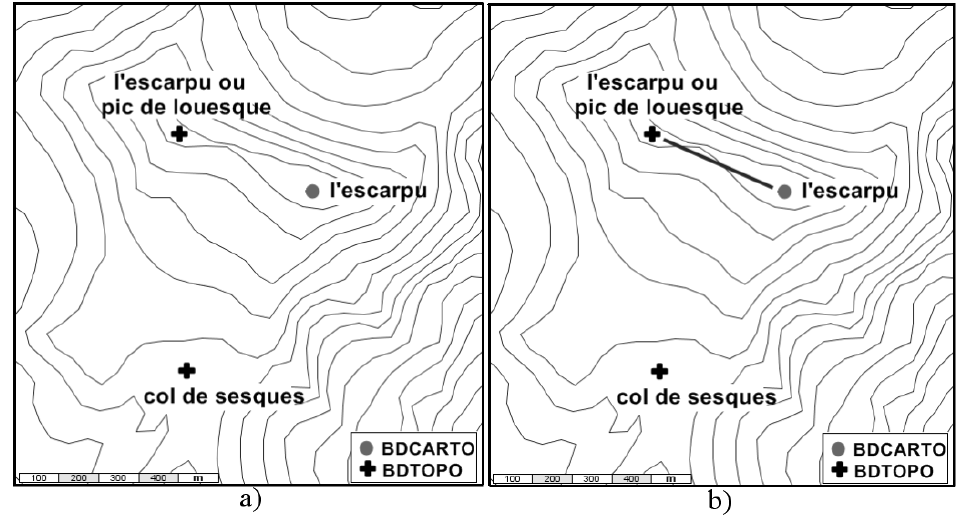
Figure 5: Isolated points matching results using a) Position and Toponym criteria and b) Position, Toponym and Semantic